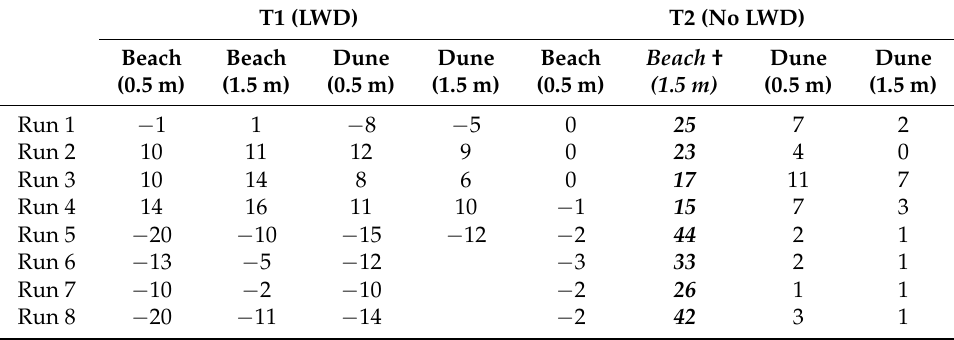
Table 3. Average flow direction deviation (degrees) by anemometer relative to T2B 1.5 . Negative values indicate a more alongshore flow while positive values indicate a more onshore flow. T1D 1.5 is missing for runs 6–8 due to a sensor malfunction. † T2B 1.5 shows the deviation of the average incoming approach angle relative to the dune crest to show the obliquity of flow (bold italicized = reference). T1 (LWD) T2 (No